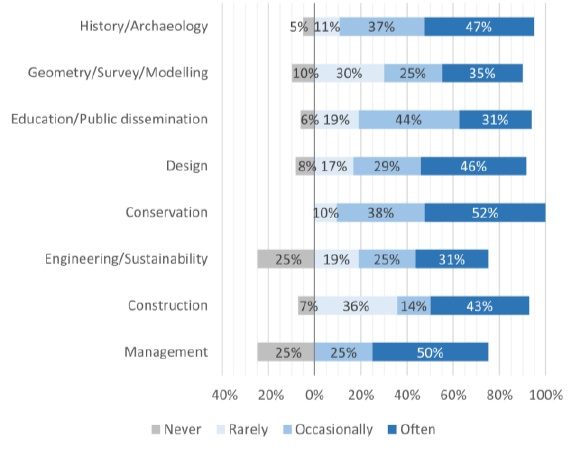
Figure 18: Access needed for archaeologic/historic data by the different groups.